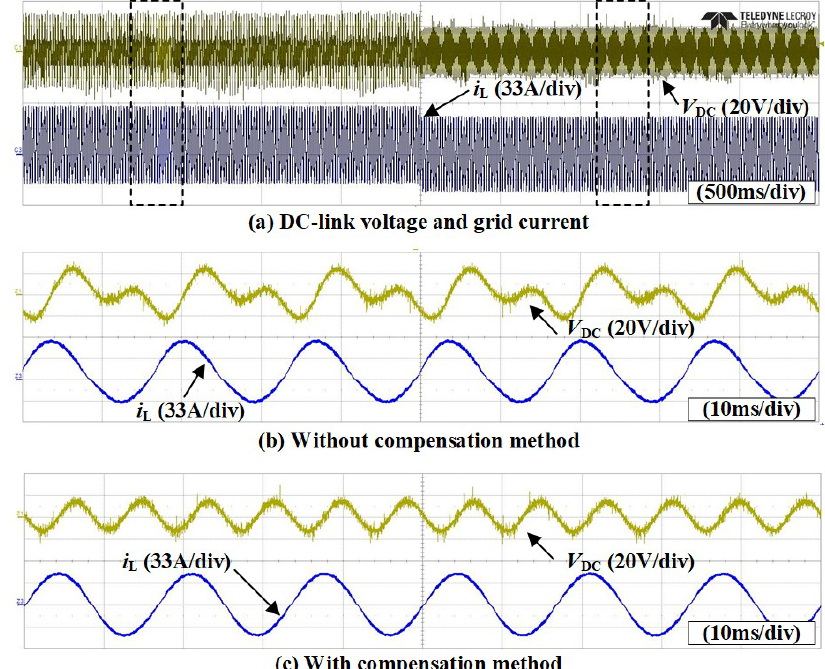
Figure 15. Experimental results of DC offset compensation method: ( a ) Waveforms of DC-link voltage and grid current, ( b ) waveforms with DC offset current ( c ) waveforms with the proposed DC offset compensator.